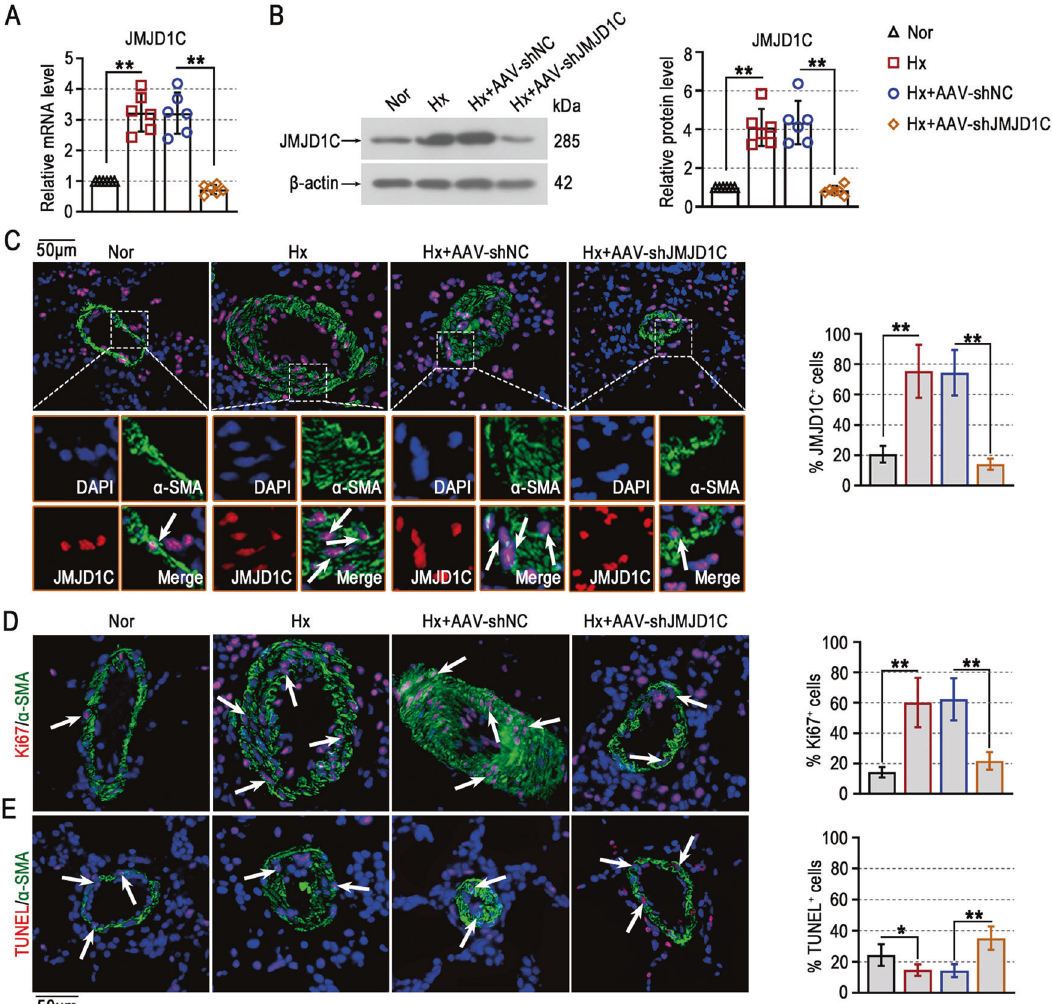
immuno fl uorescence staining of α -SMA (green) and JMJD1C (red) (left panel). DAPI was used to stain cell nuclei (blue). Arrows indicate the coexpression of α -SMA and JMJD1C in pulmonary arteries. The percentage of JMJD1C + cells in pulmonary arteries (stained with α -SMA) was quanti fi ed (right panel). Bar = 50 μ m. D Representative immuno fl uorescence images of lung sections stained with anti- α -SMA antibodies (green) and anti-Ki67 antibodies (red) (left panel). DAPI was used to stain cell nuclei (blue). Arrows indicate the colocalization of α -SMA and Ki67 in pulmonary arteries. The percentage of Ki67 + cells in pulmonary arteries (stained with α -SMA) was quanti fi ed (right panel). Bar = 50 μ m. E Representative immuno fl uorescence images of lung sections stained with anti- α -SMA antibodies (green) and TUNEL (red) (left panel). DAPI was used to stain cell nuclei (blue). Arrows indicate the colocalization of α -SMA and TUNEL in pulmonary arteries. The percentage of TUNEL + cells in pulmonary arteries (stained with α -SMA) was quanti fi ed (right panel). Bar = 50 μ m. Nor Normoxia, Hx Hypoxia. The values are the mean ± SD, and statistical signi fi cance was determined by one-way ANOVA. N = 6, * p < 0.05, ** p <